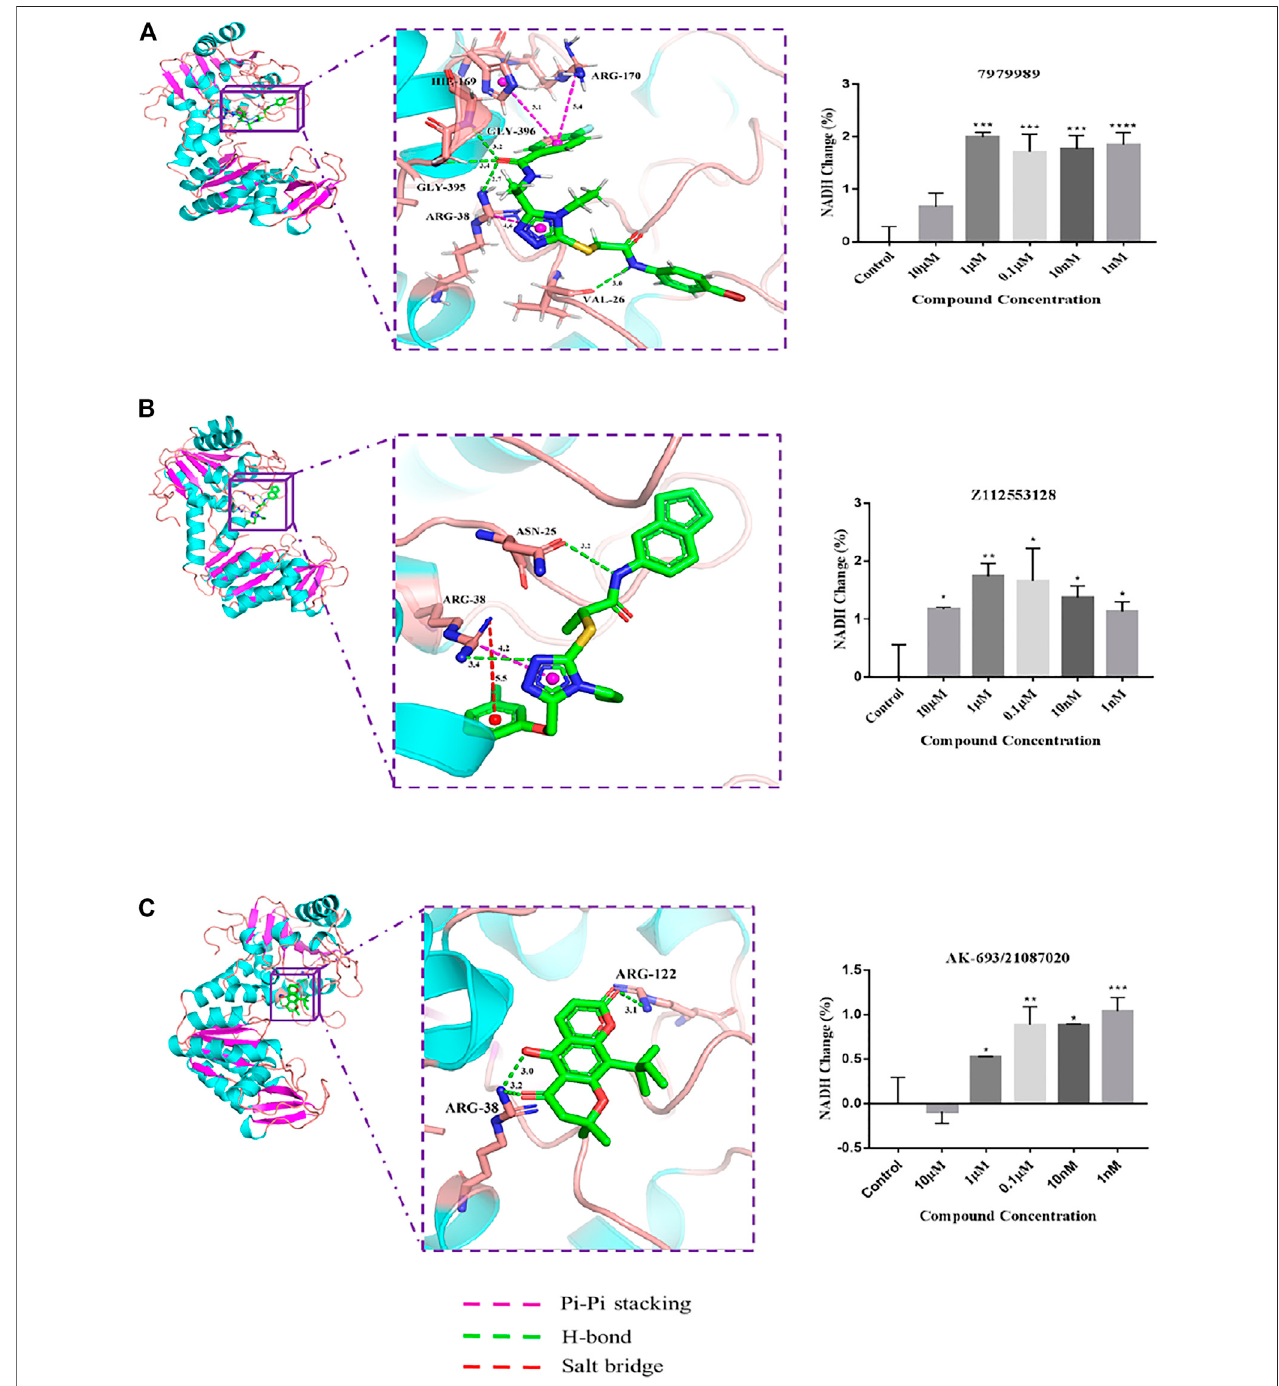
FIGURE 3 | The intermolecular interaction of the predicted binding modes of (A) 7979989; (B) Z112553128; (C) AK-693/21087020. Effect of these three compounds on the activity of puri fi ed human PGK1 enzyme. **** p < 0.0001; *** p < 0.005, ** p < 0.01, * p < 0.05 vs. control group. Each bar represents the mean ± standard deviation (SD) calculated from three independent